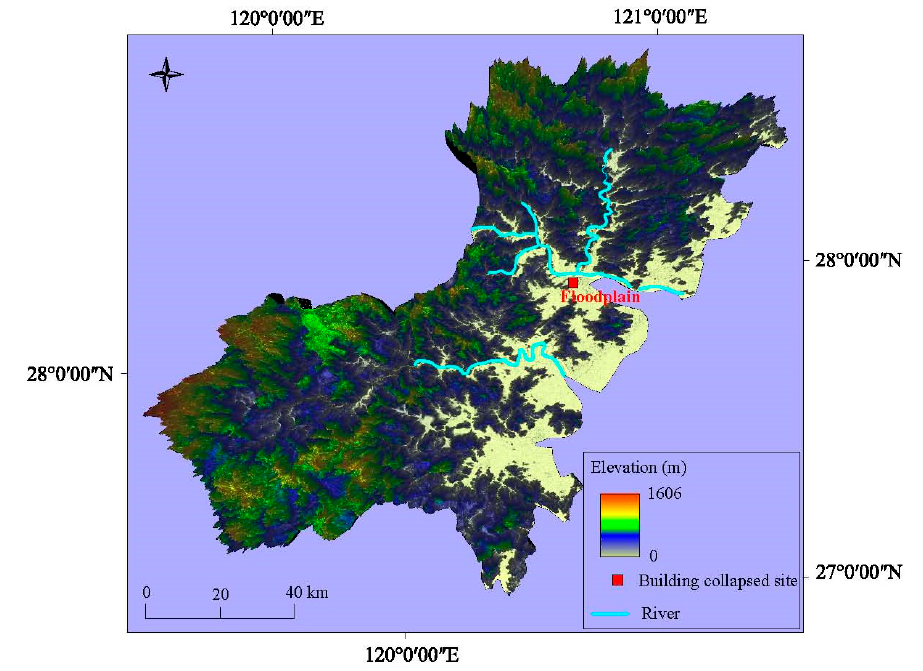
Figure 5. Topography of Wenzhou City.